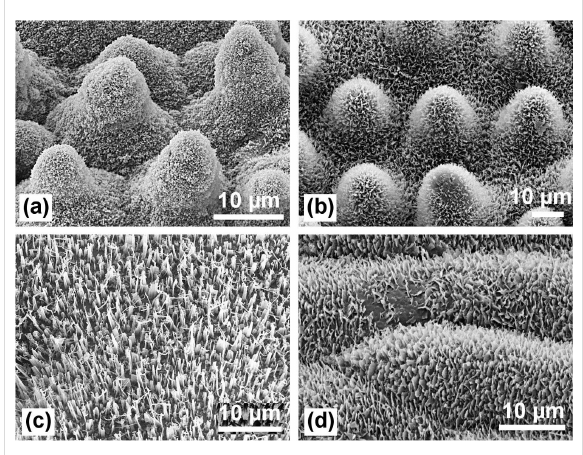
Figure 7: Traces of natural erosion of the waxes on the same leaves as in Figure 6: (a) Nelumbo nucifera (Lotus); (b) Euphorbia myrsinites ; (c) Brassica oleracea ; (d) Yucca filamentosa . On the papillose leaves (a,b) the eroded areas are limited to the tips of the papillae. On